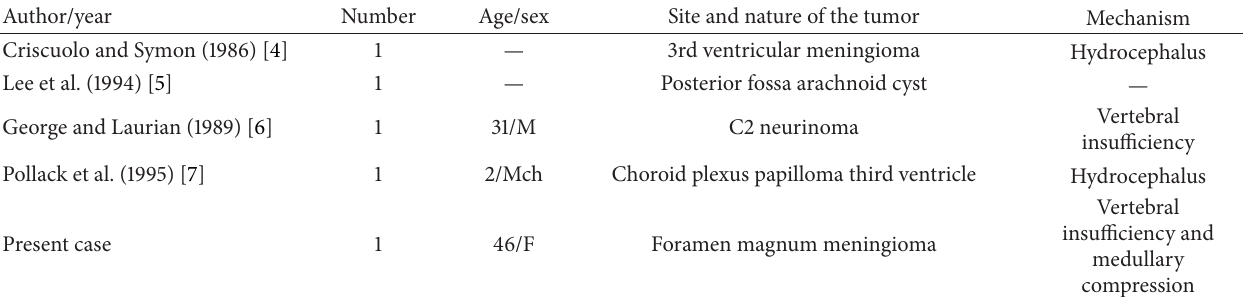
Table 1: Tumors causing drop